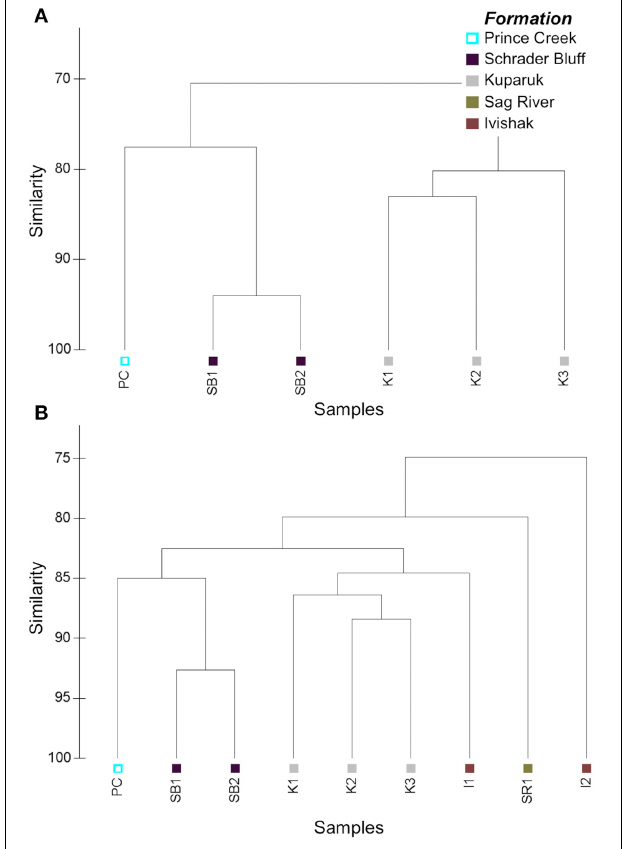
OTU in Class Thermoplasmata, and Archaeoglobus (Table